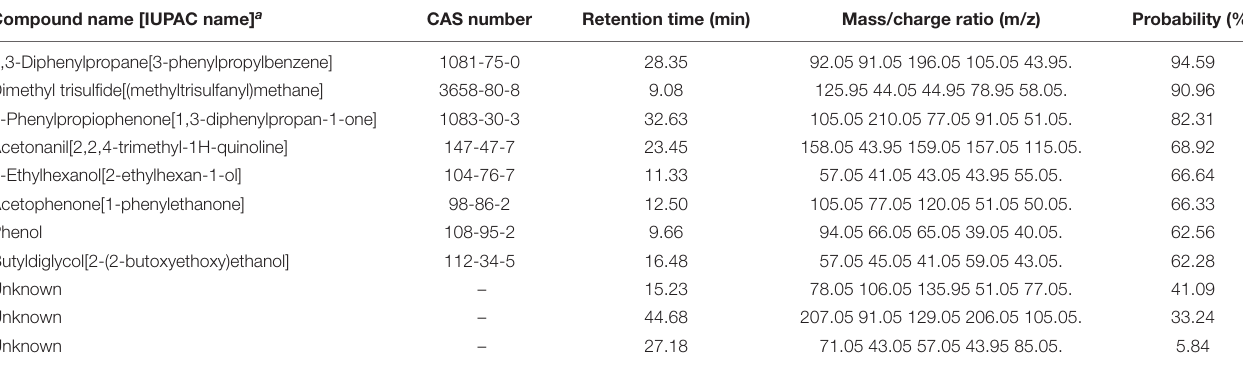
FIGURE 3 | Experiment D . Effect of different agar media on the production of anti-Basidiomycete volatile organic compounds (VOCs) by Pseudomonas protegens strains CHA0 and CHA77. Photos were taken 10 days after the plates were joined and sealed, i.e., 10 days of exposure to P. protegens ’ VOCs. The photos show colonies of Heterobasidion abietinum strain 10 grown on potato dextrose agar (PDA) and exposed to VOCs emitted by CHA0 or CHA77 grown on different media such as PDA, Luria-Bertani agar (LBA), King’s B agar (KBA), or peptone agar (PA), either with NaCl and glycine or not. Halos around the colonies were due to diffusible substances secreted by the fungus and did not contain hyphae. In the graph, error bars are the standard error of the mean of three replicates (plates). Bars with different letters are significantly different according to the LSD test ( P < 0.05). TABLE 1 | Experiment G. Volatile compounds differentially produced by Pseudomonas protegens CHA0 grown on Luria-Bertani agar (LBA) compared to the same bacterium grown on potato dextrose agar (PDA) and to the non-inoculated